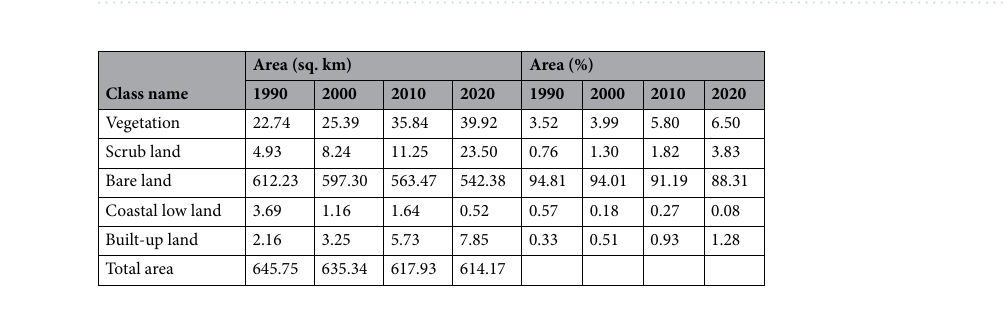
Table 3. Area calculation of different LU/LC classes of Farasan